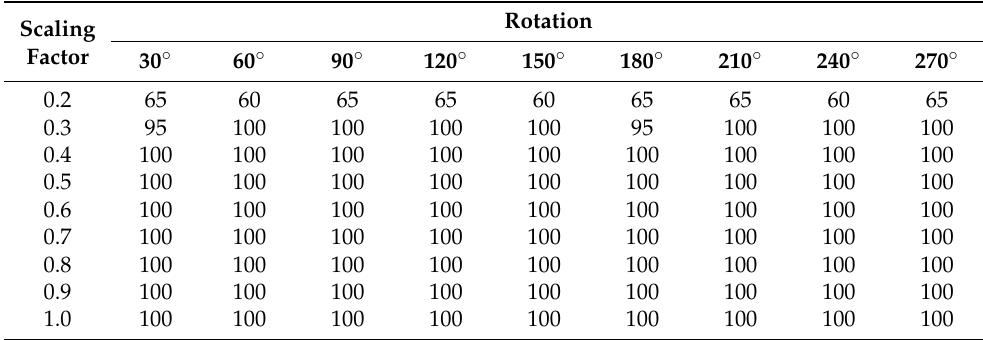
Table 5. The correct recognition rates for a combination of rotation angles and scaling factors for the log-polar-FFT2 method for the 2D aircraft dataset.